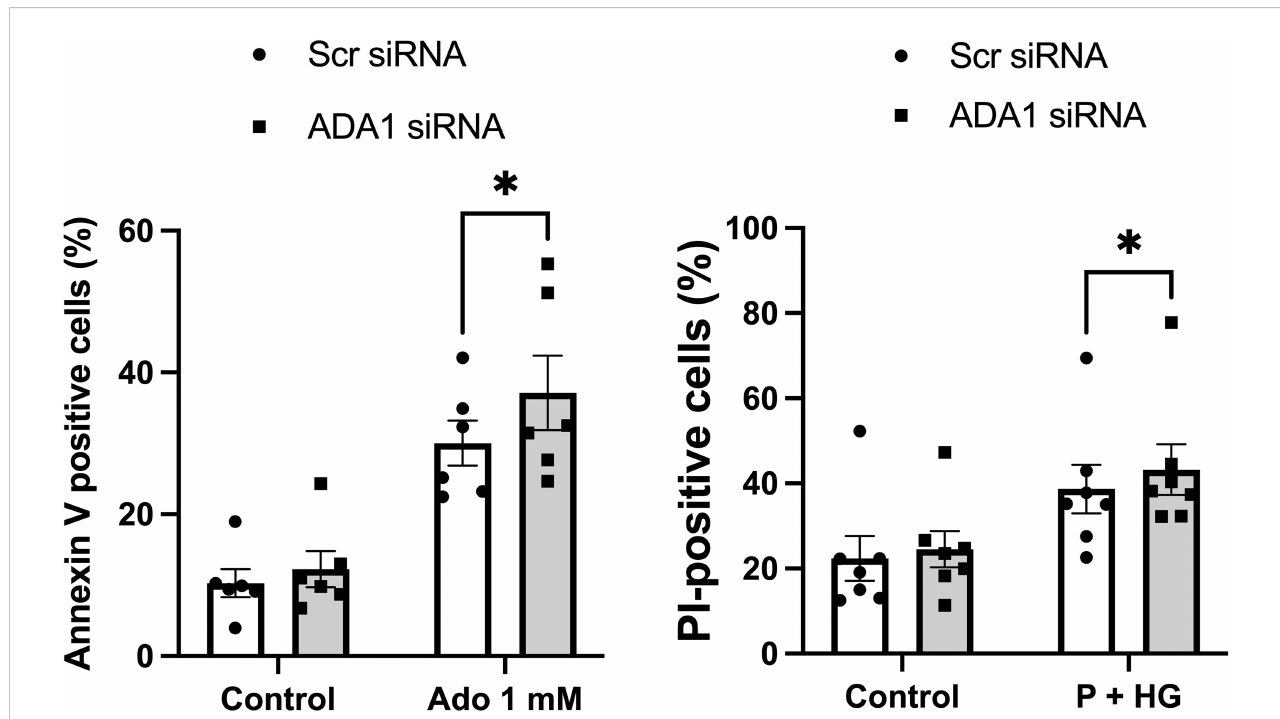
FIGURE 7 Knockdown of ADA1 results in increased cell death in response to adenosine or high glucose + palmitate. EndoC-betaH1 cells were lipofected with scramble (Scr) or ADA1 siRNA. Two days later cells were treated with 1 mM adenosine (Ado 1 mM) (left panel) or with palmitate + high glucose (P + HG) (right panel). The next day cells were analysed by fl ow